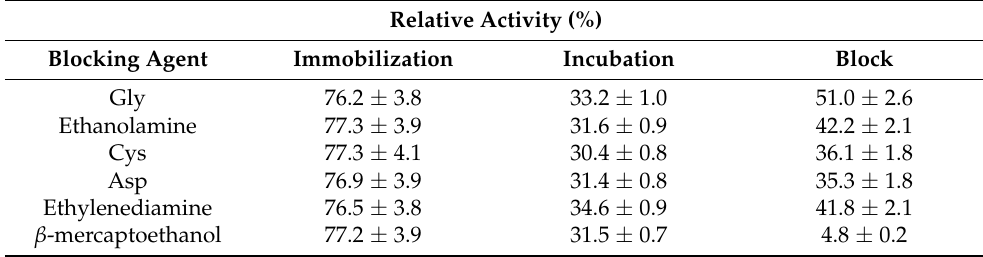
Table 5. Effect of the blocking agent (2 M) in the relative hydrolytic activity (considering 100% of the initial activity utilized in the immobilization) of PGA biocatalysts immobilized at pH 7 and incubated for 5 h at pH 10.0. The experiments were conducted as described in the Methods Section.